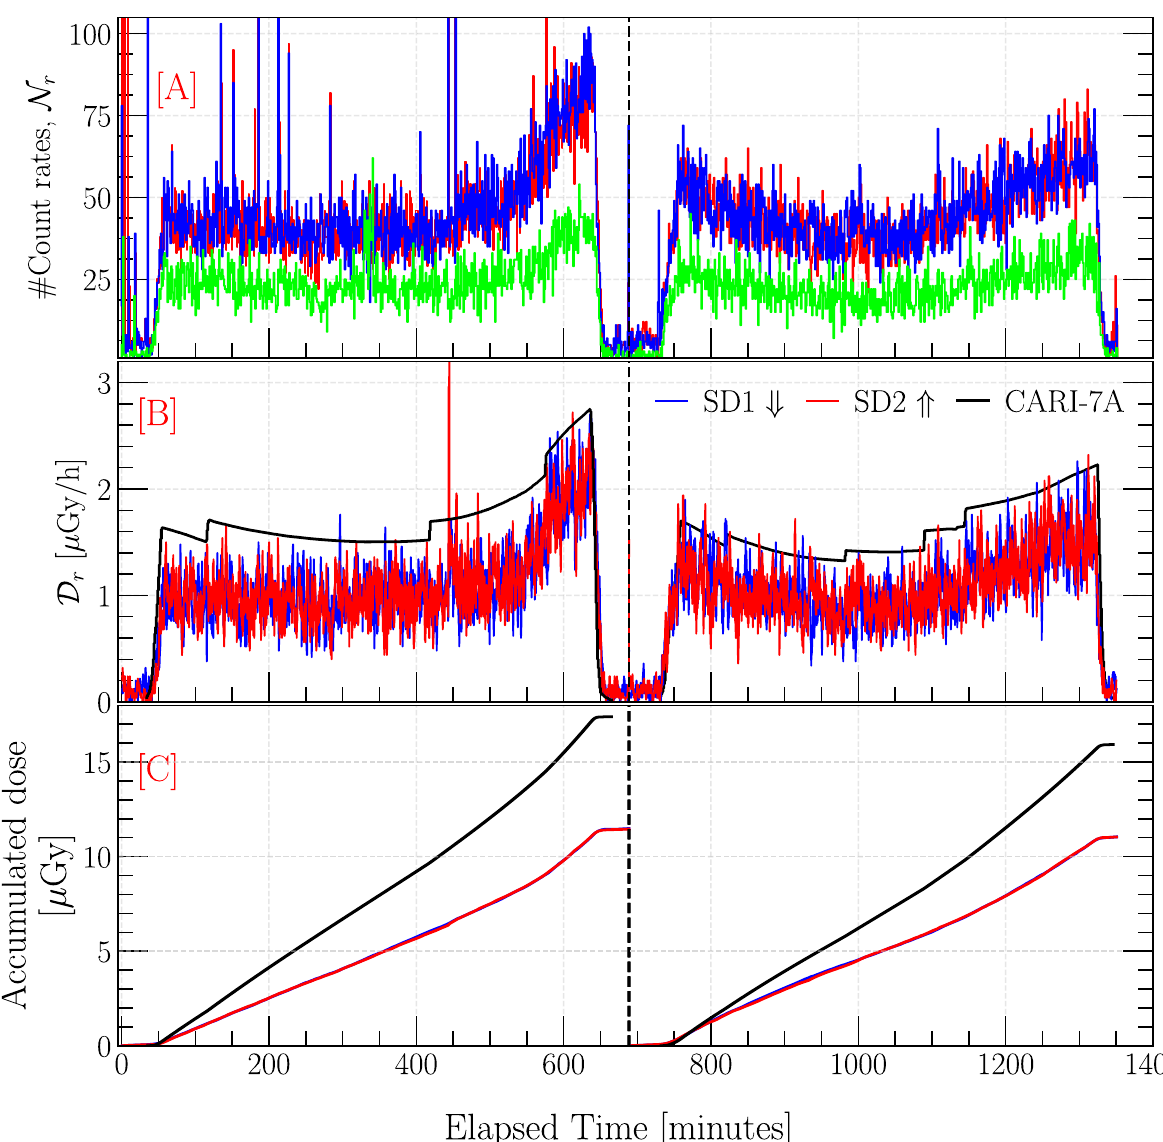
Figure 2. Panel A shows the measured count rates (SD 1 in blue, SD 2 in red, and coincidence counts in green) during the two tests. Panel B shows the measured absorbed dose rate in each diode, with a minute cadence, while panel C shows the accumulated absorbed dose, D a . The black curves in the bottom panels show results for the CARI-7A model for 0.3 mm of silicon. The left panels are for the fl ight from FAJS to EDDF and the right panels are for EDDM to FASJ. Supplementary data are available on the